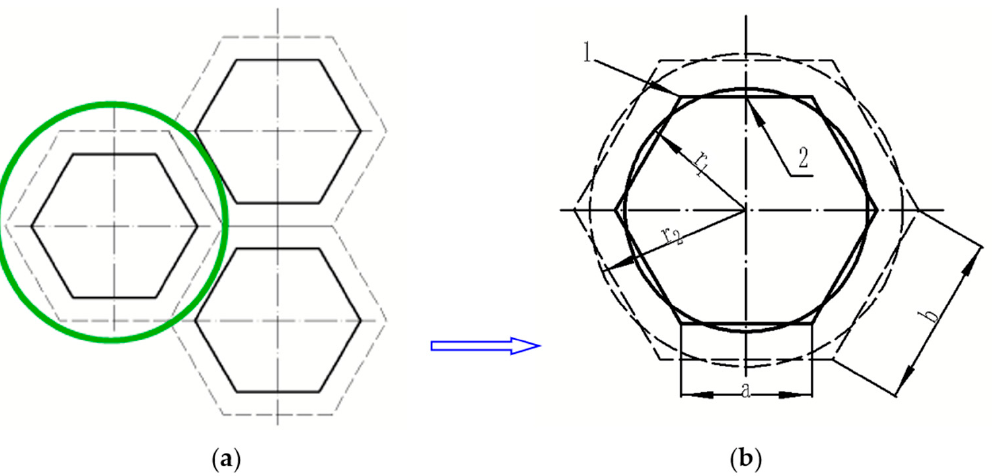
Figure 2. Simplified diagram of single–grid physical model ( a ) HTGR section ( b ) single–grid physical model.